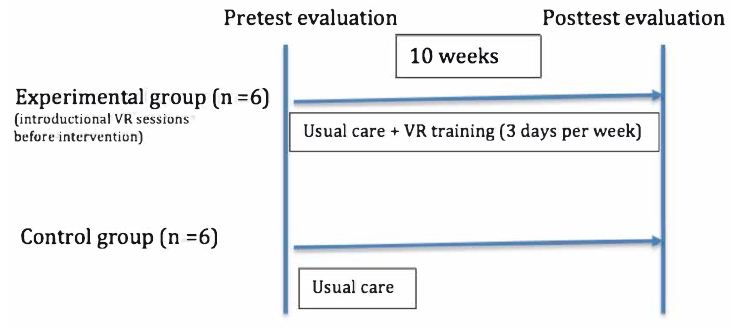
Figure 2. Study design: evaluation and timeline.